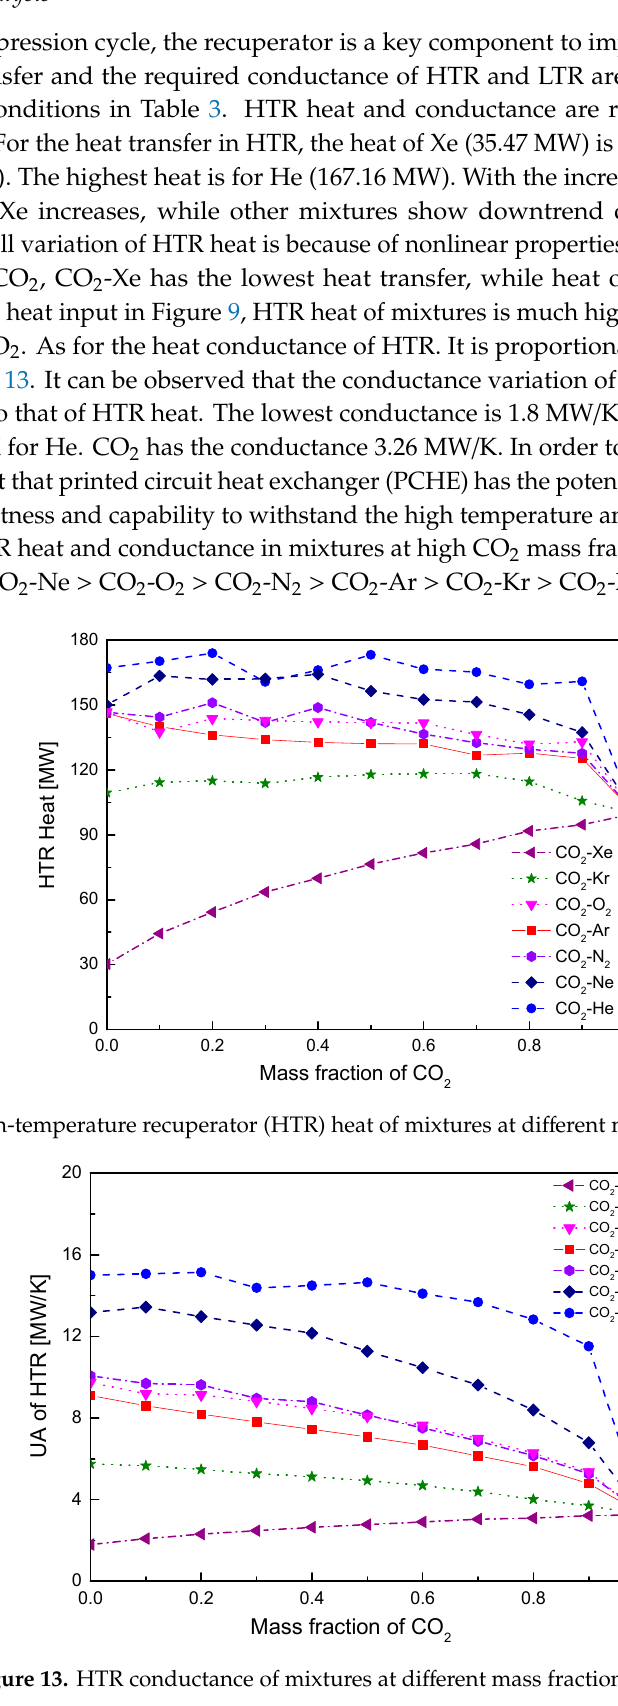
Figure 13. HTR conductance of mixtures at different mass fractions of CO 2 .